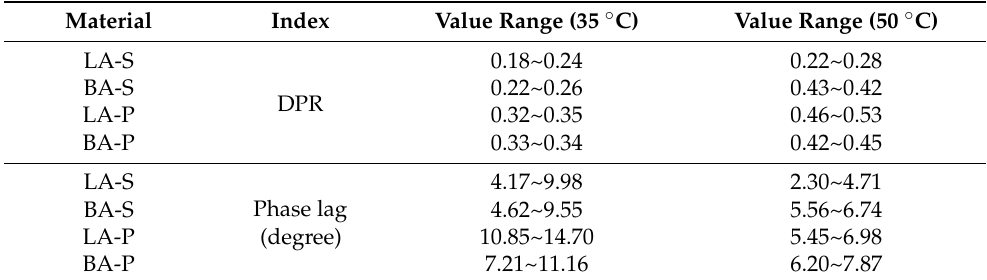
Figure 6. The DPR at 35 °C and 50 °C ( a ), and the phase lag of the mixes at 35 °C and 50 °C ( b ). Table 7. The value range of DPR and phase lag of the four mixtures at 35 °C and 50 °C.